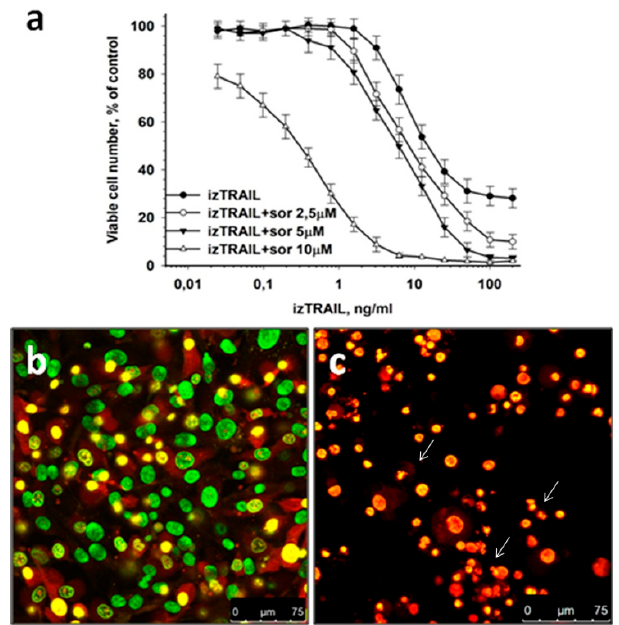
Figure 2. Suppression of confluent izTRAIL resistance by 10 µM sorafenib. ( a ) Cell viability vs. concentration of izTRAIL in confluent (96 h after seeding) cultures in one day after the addition of izTRAIL and sorafenib, n = 5; ( b , c ) representative images of confluent cultures in one day after the administration of 10 µM sorafenib and a combination of 10 µM sorafenib and 1.5 ng/mL izTRAIL, respectively. The cultures were stained with nuclear dyes H33342 and PI, 1 mkg/mL each. Green nuclei—viable cells, yellow-red nuclei—dead cells. Aberrant allocation of chromatin (arrow) indicates apoptosis.